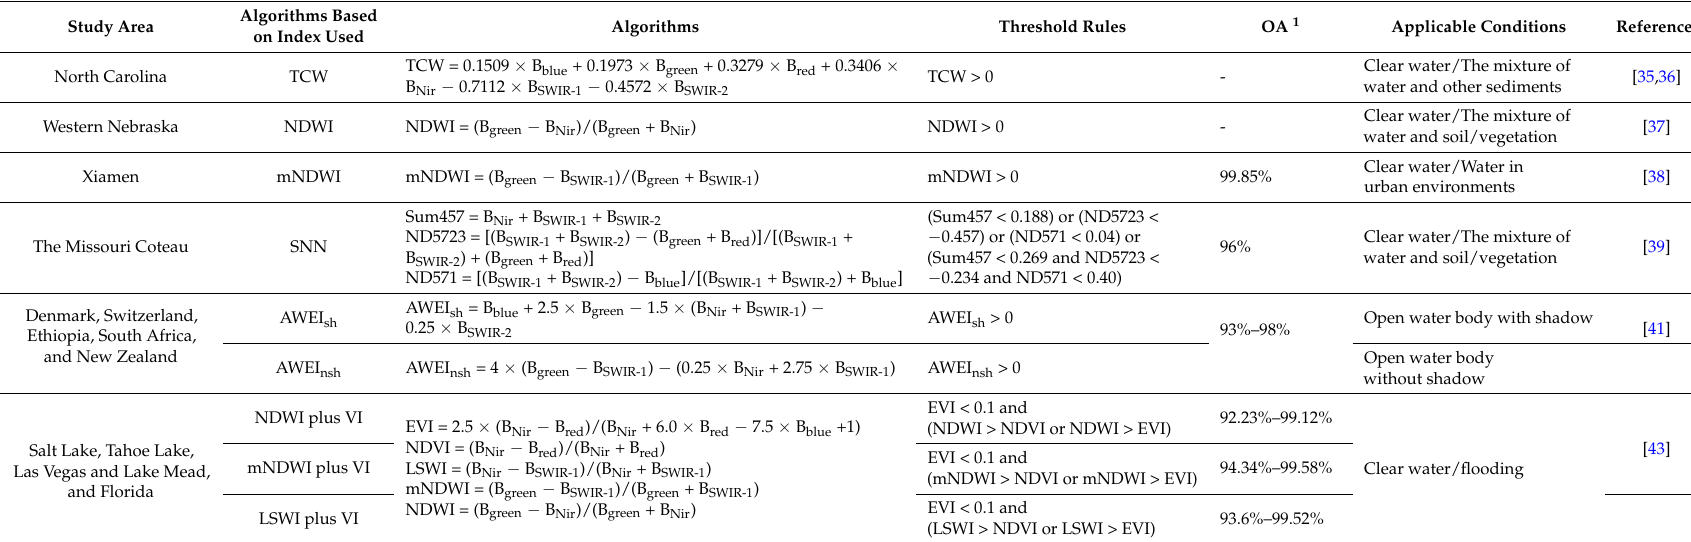
Table 2. A summary of open surface water body mapping algorithms based on different water indices and